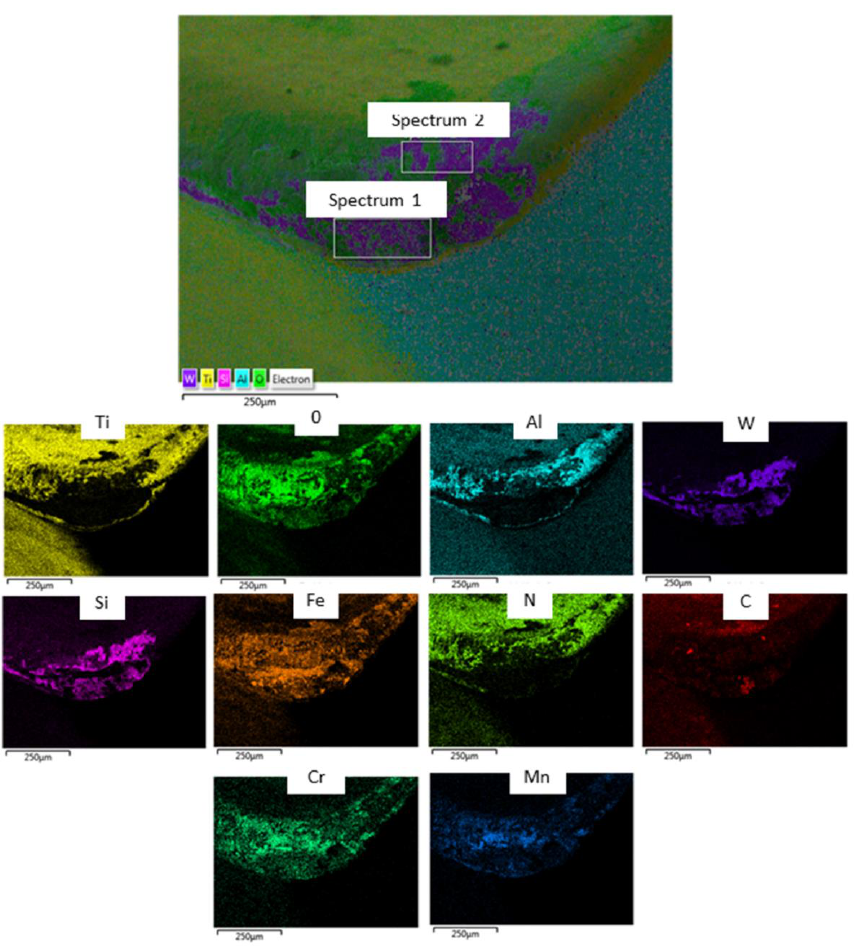
Figure 6. FESEM analysis which confirmed the existence of Fe, Mn, C particles in AISI 4340: Experi- ment 9.